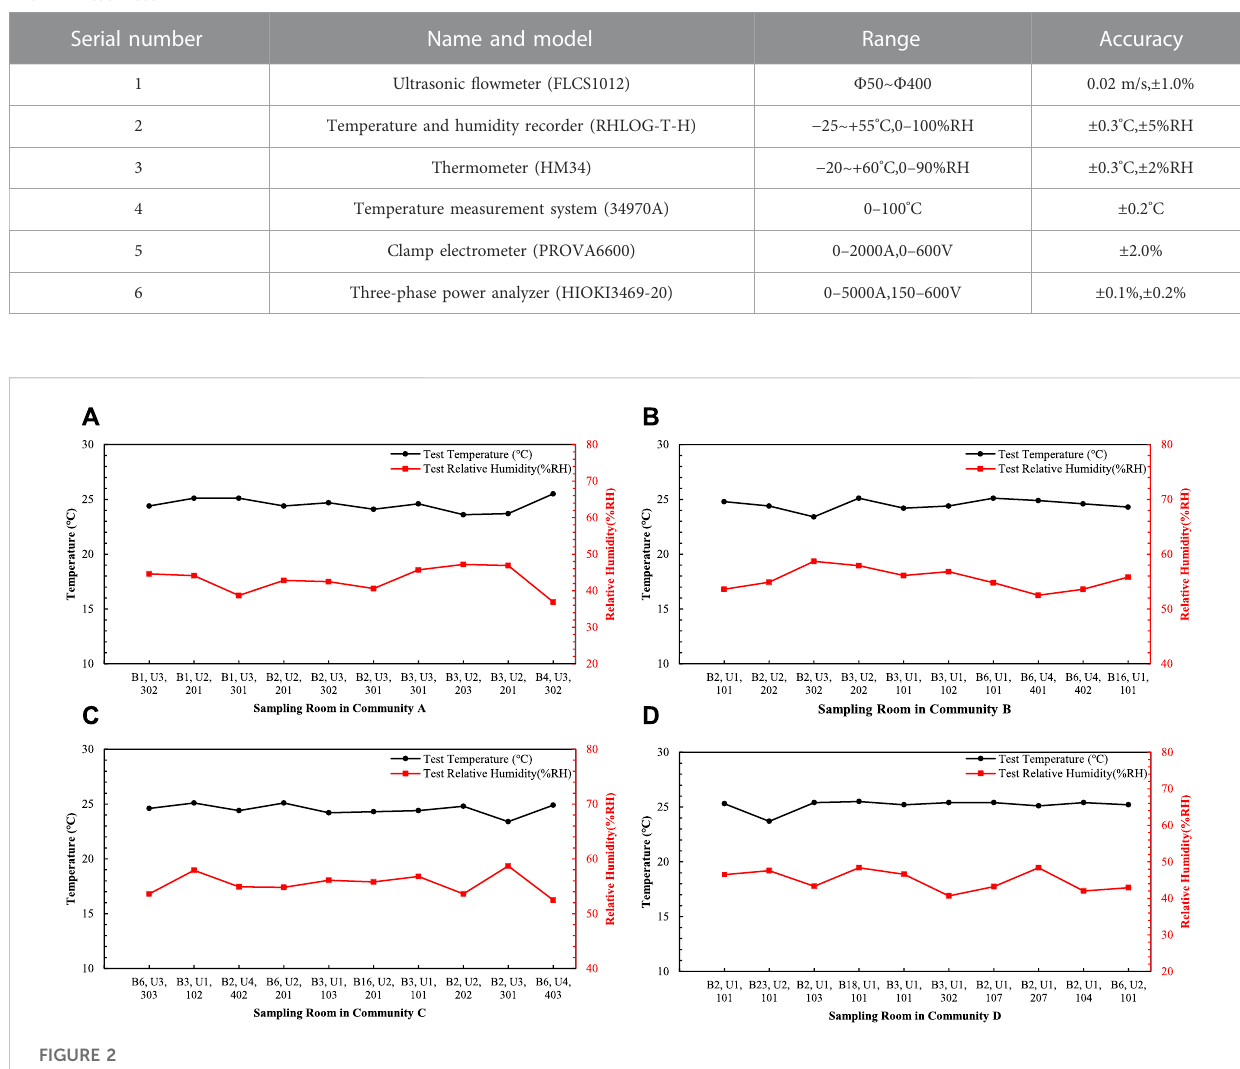
FIGURE 2 Test results for room temperature and relative humidity. (A) The temperature and humidity of the sampling room in Community A; (B) The temperature and humidity of the sampling room in Community B; (C) The temperature and humidity of the sampling room in Community C; (D) The temperature and humidity of the sampling room in Community